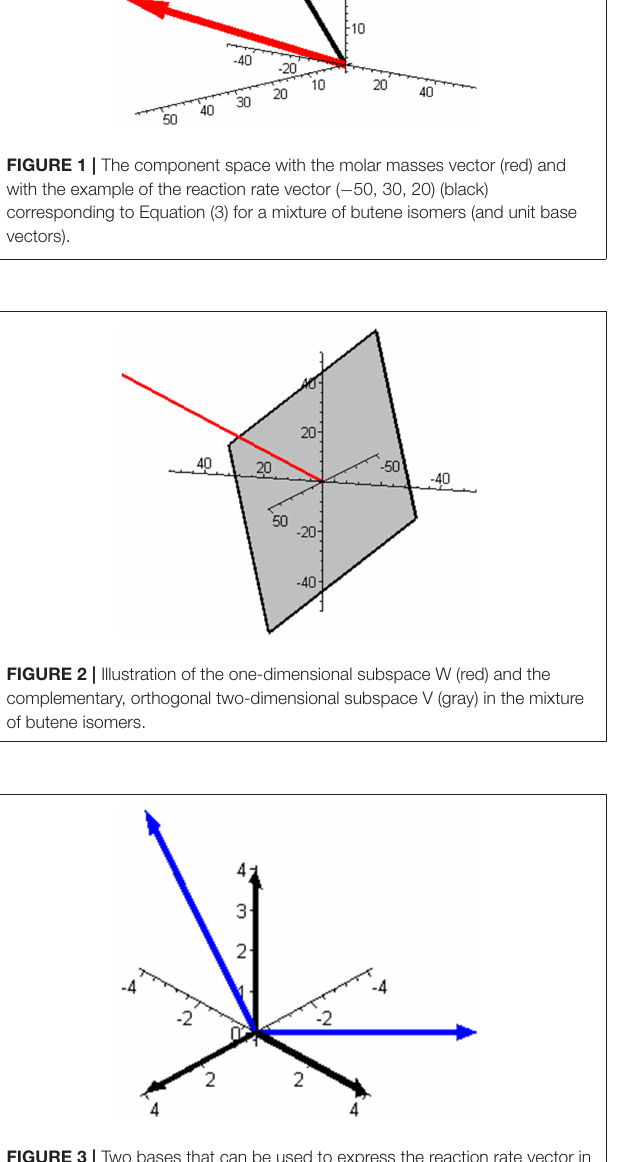
FIGURE 3 | Two bases that can be used to express the reaction rate vector in the mixture of butene isomers. The basis of the component space, leading to three component rates as coordinates of J , is shown using black arrows. The basis of subspace V, illustrated in Figure 2 and leading to two independent reaction rates as coordinates of J , is shown using blue